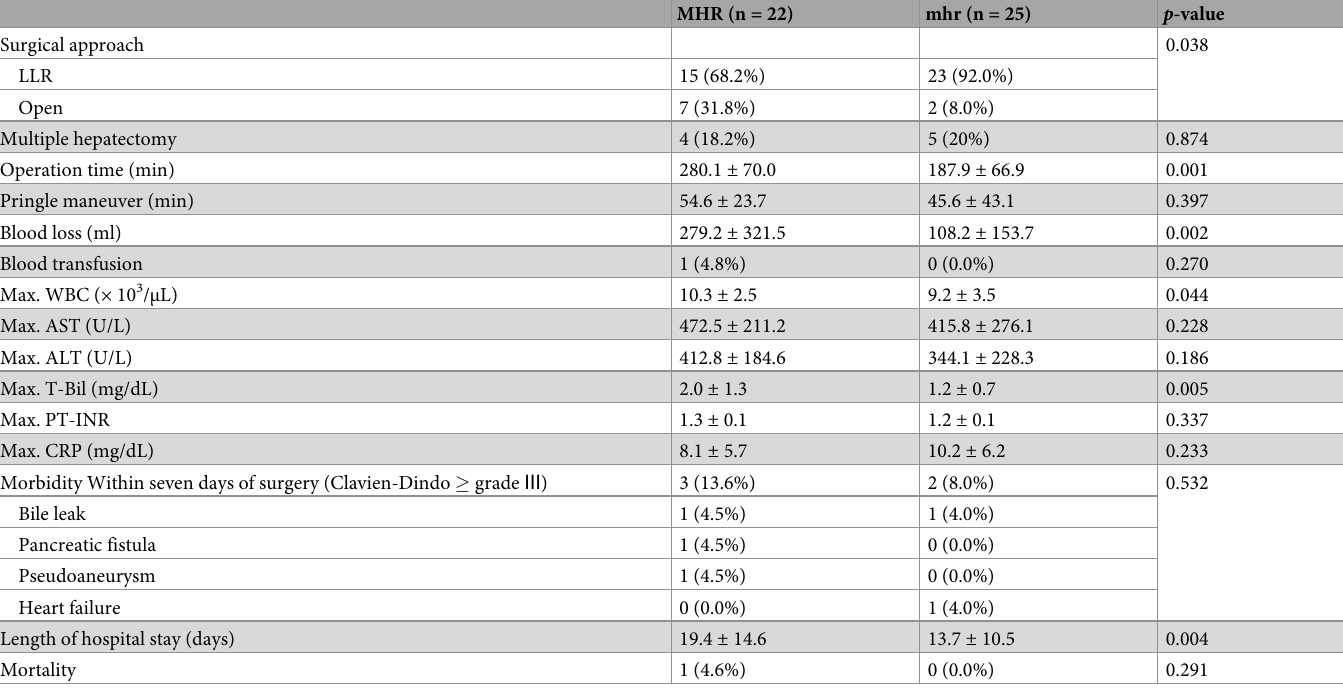
Table 2. Comparison of surgical outcomes after major hepatic resection and minor hepatic